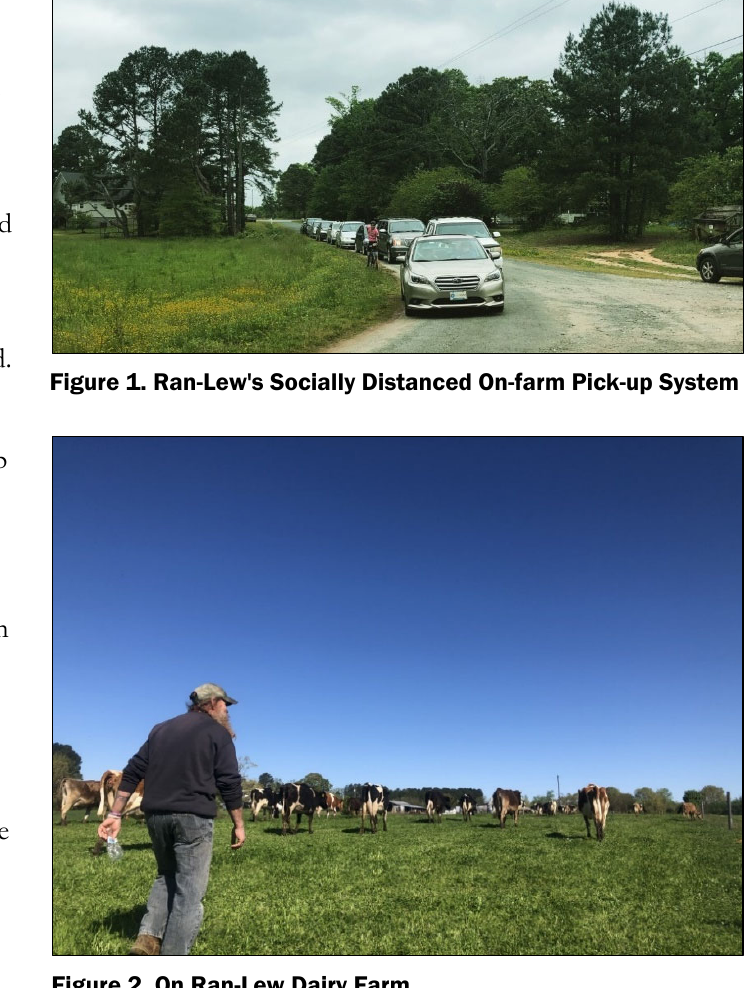
Figure 2. On Ran-Lew Dairy Farm